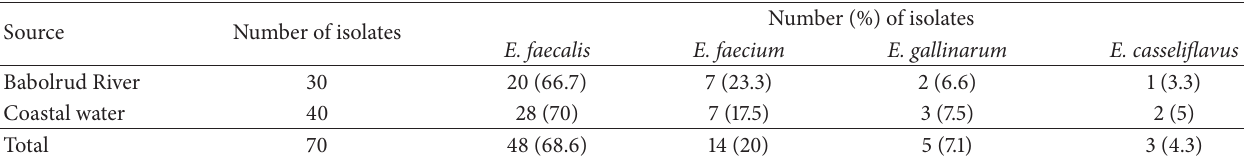
Table 2: Species distribution of Enterococcus spp. isolated.